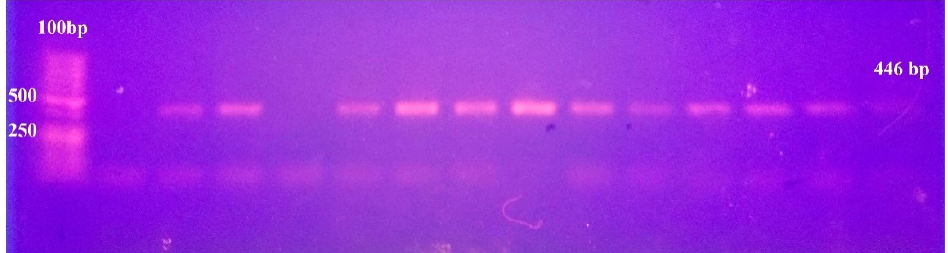
Figure 1. Confirmatory PCR for identification of C. albicans isolates. Lane 1: 100 bp ladder, lanes 2, 4 showed negative results, while the rest of lanes had a PCR products of C. albicans isolates with a band of 446 bp.